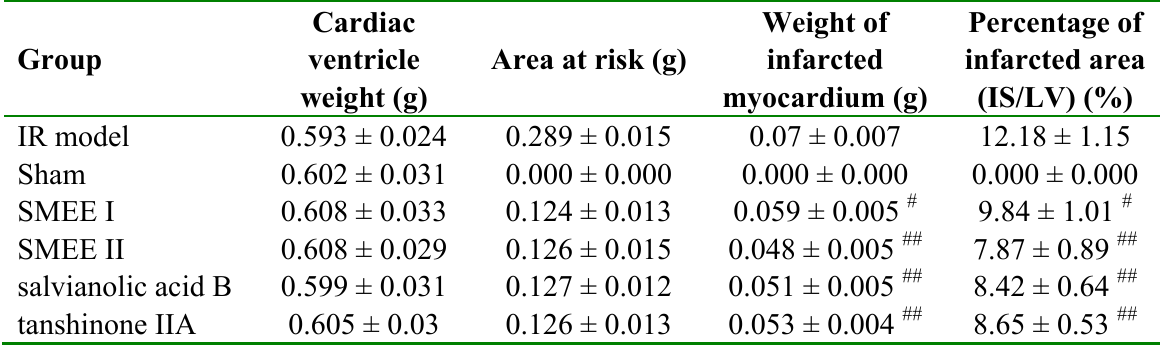
Table 2. Effect of S. miltiorrhiza ethanol extract on the cardiac ventricle weight, the weight of infarcted myocardium and percentage of infarcted